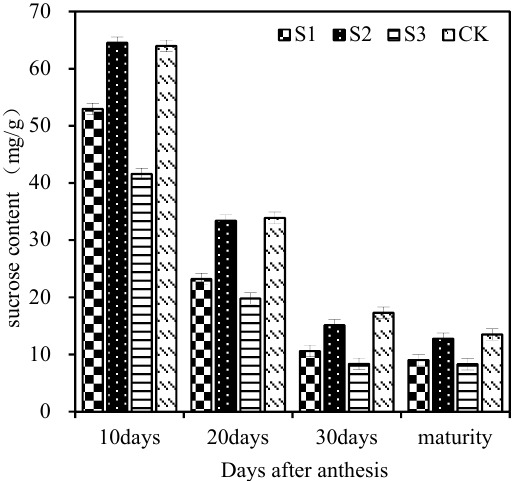
Figure 4. Effects of different leaf cutting methods on grain SS enzyme activity. S1, cut three leaves; S2, cut the remaining leaves except for the upper three leaves; S3, cut whole leaves; CK, normal plants. Vertical bars represent ± SE of the mean.